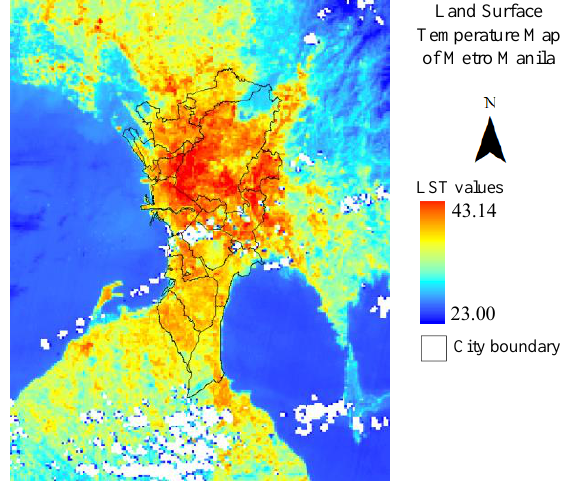
Figure 9. Land Surface Temperature Map of Metro Manila in February 2019. Red areas are warmer regions while blue areas